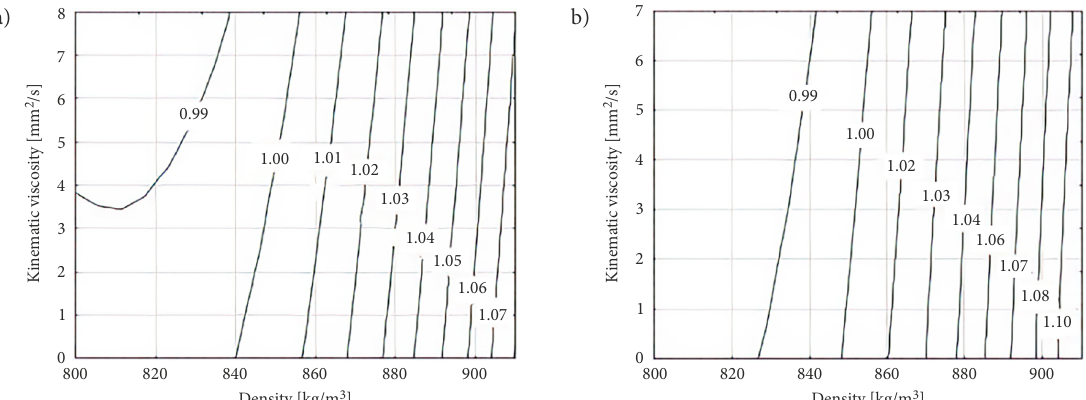
Figure 9. Multivariate characteristics of relative BSFC change in ChN 26.5/31 engine working with diesel: